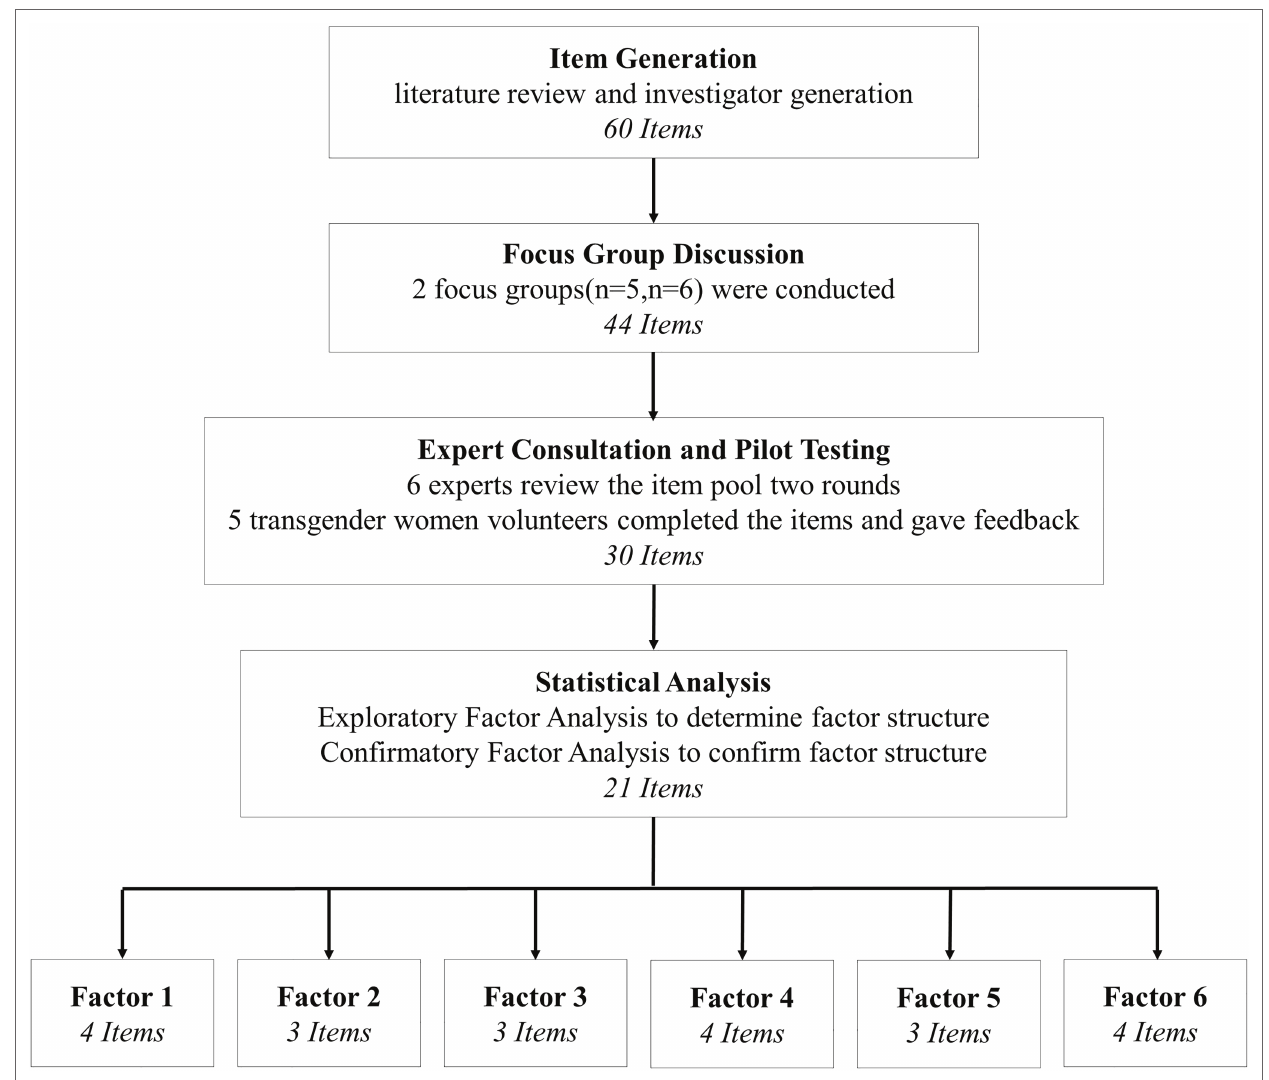
FIGURE 1 | Flowchart of the Gender Identity Scale for Transgender Women (GIS-TW)